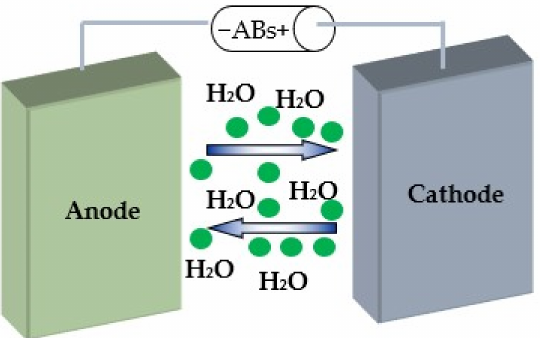
Figure 2. Schematic presentation of aqueous batteries. The anode and cathode are separated by a membrane filled with monovalent or multivalent ions (green circles) in aqueous